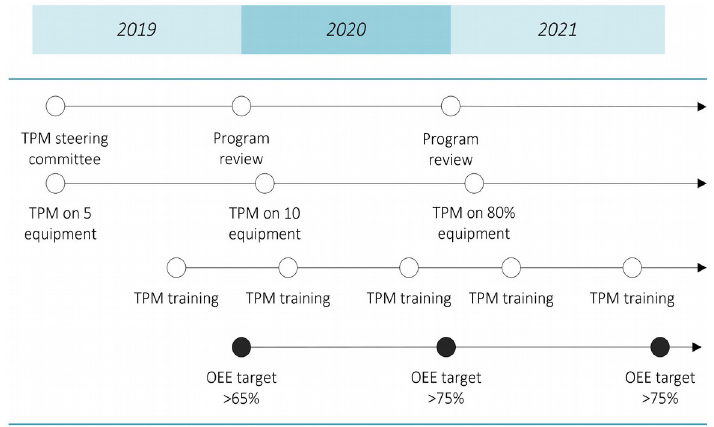
Figure 5. Implementing TPM roadmap